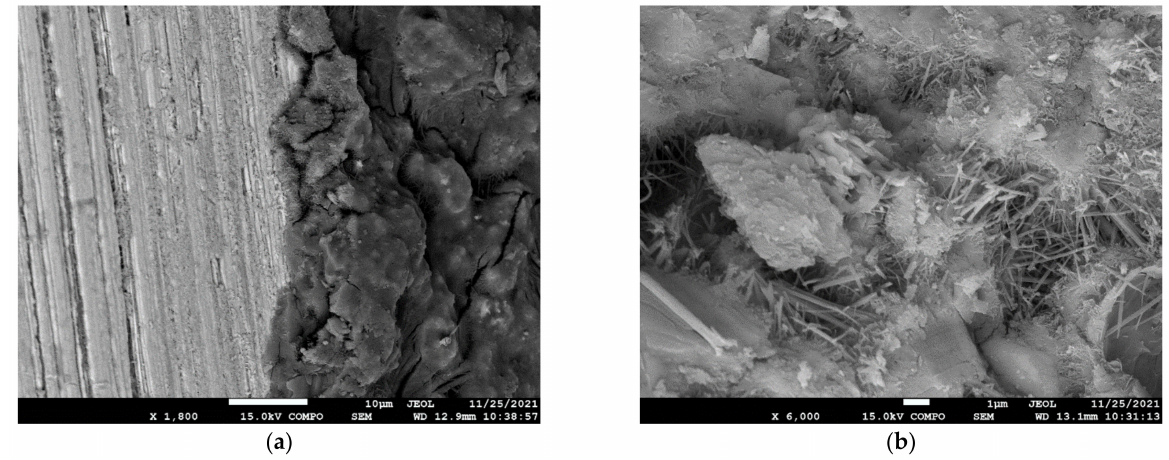
Figure 13. Microstructure ( a ) scale 1800 × ( b ) scale 6000 × — fiber-reinforced concrete (90 kg/m 3 ).